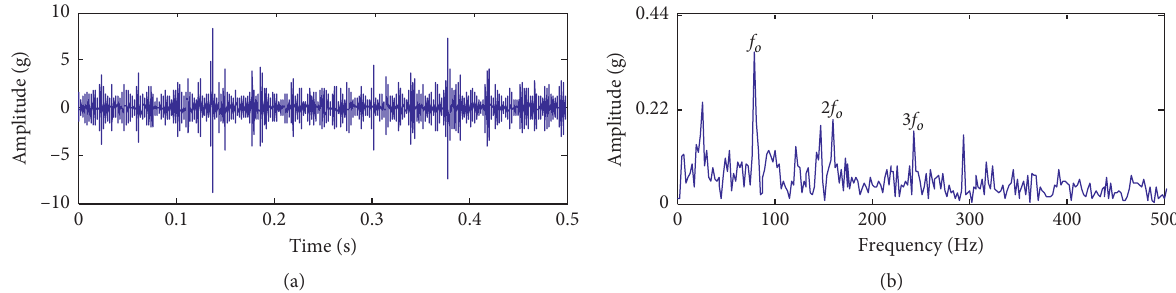
Figure 22: Analysis results of engineering signal by CYCBD with optimal parameters: (a) the waveform of deconvolution signal; (b) the envelope spectrum of deconvolution signal.